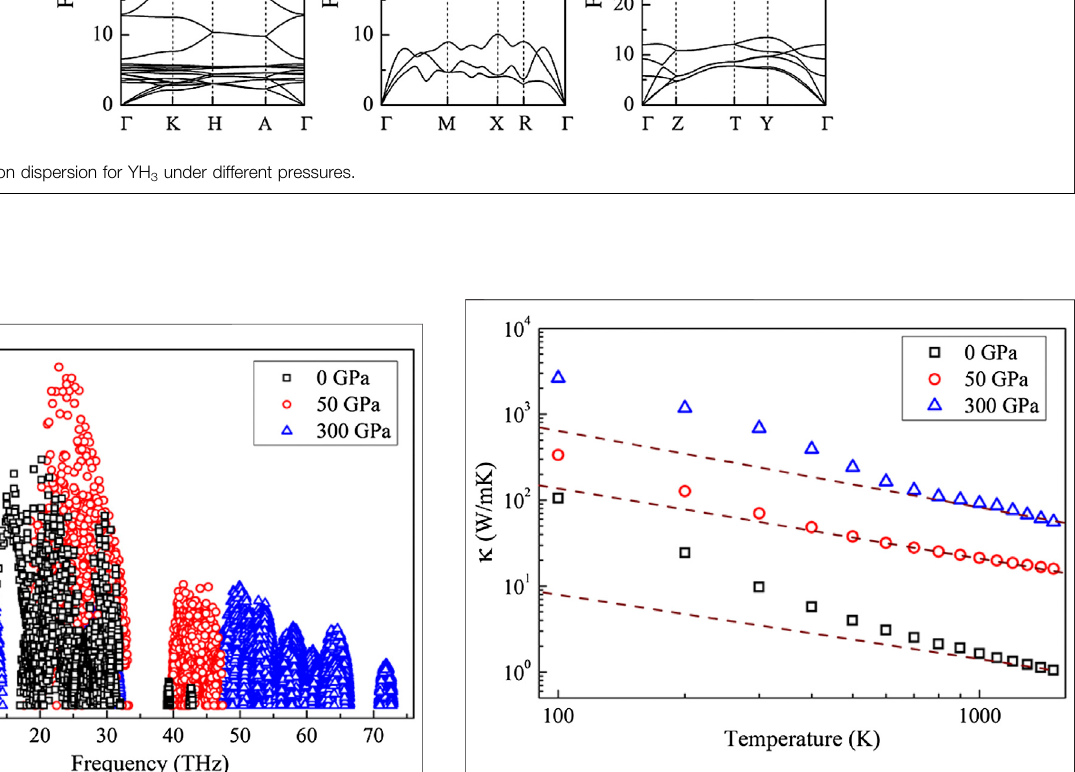
Frontiers in Materials |